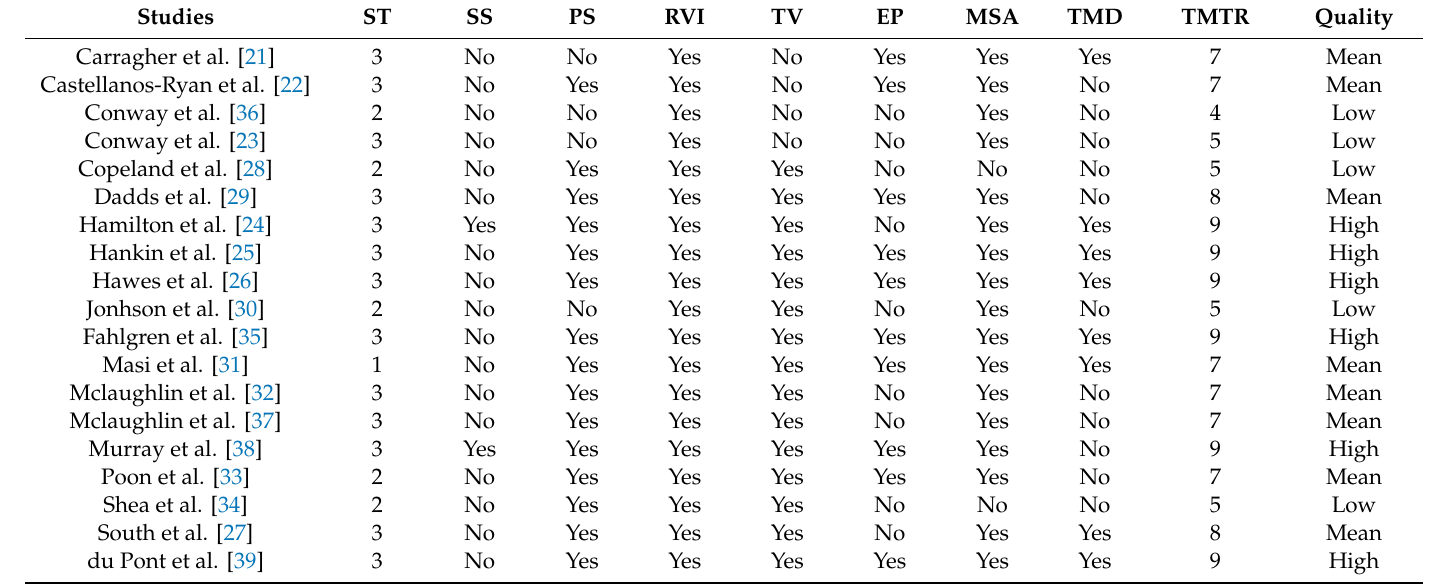
Table 5. Summary of the methodological and theoretical quality of the empirical studies reviewed that include transdiagnostic variables in antisocial disorders ( n =